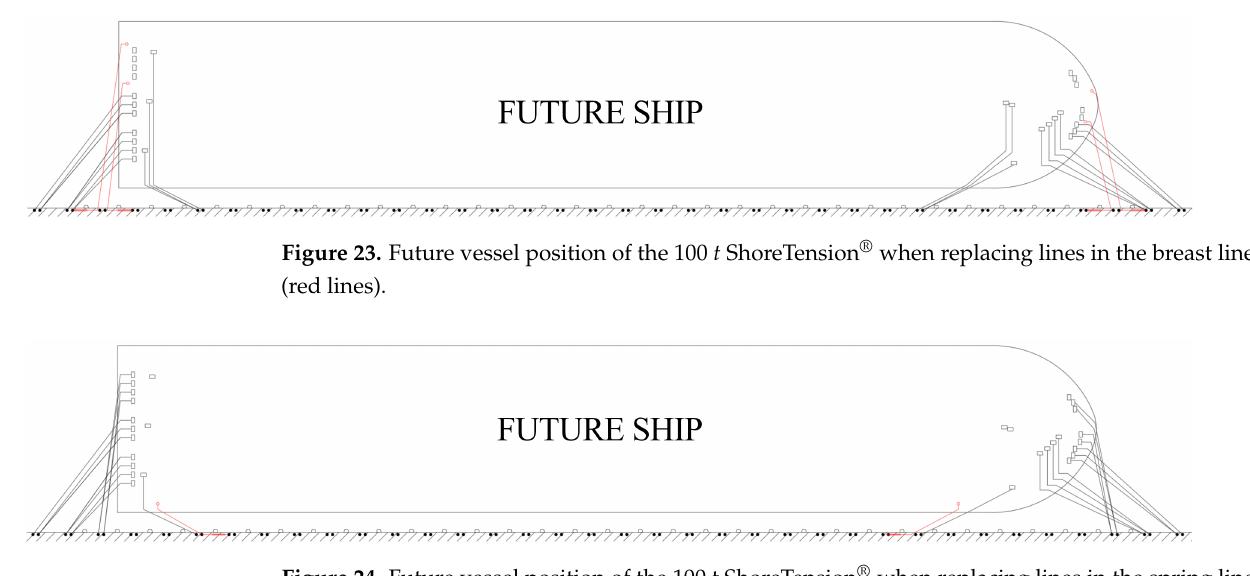
Figure 24. Future vessel position of the 100 t ShoreTension ® when replacing lines in the spring lines (red